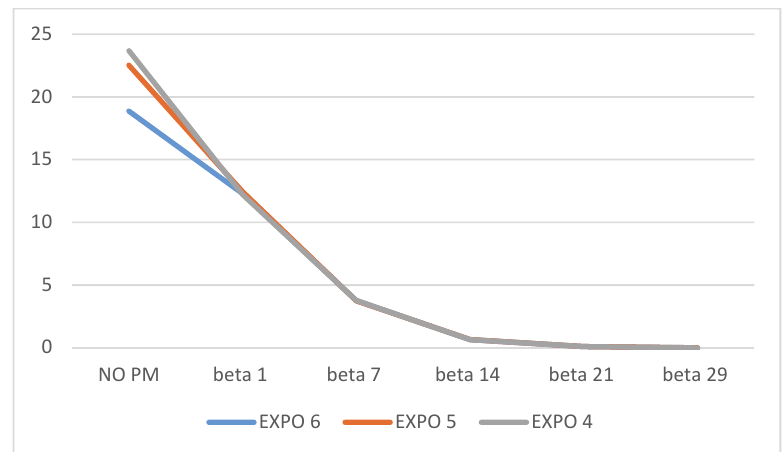
Fig. 6. Number of corrections